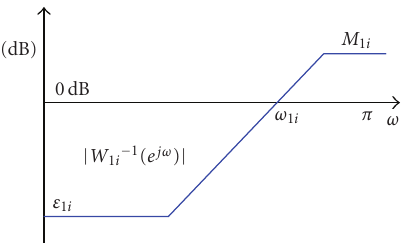
( e jω ) and its 1 i